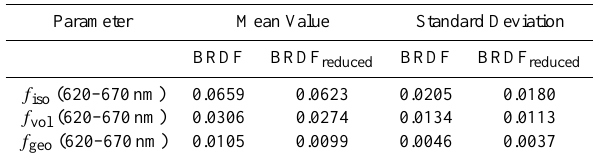
Table 1. Statistical comparison between original and reduced ran- dom number BRDF distribution weighting parameters ( f iso , f vol , f geo ) for the B1 wavelength